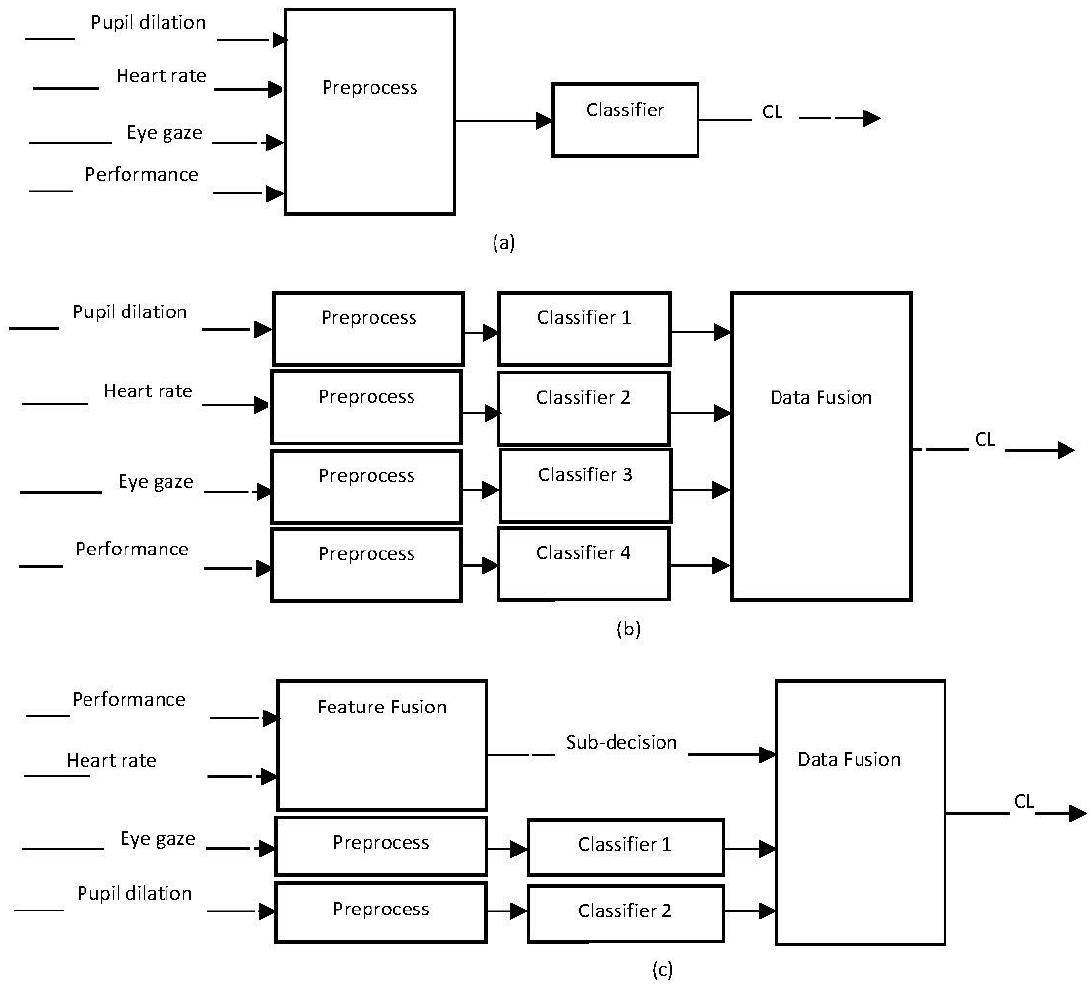
Figure 6. The structures of the three-level fusion approaches. ( a ): feature-level fusion, ( b ): decision-level fusion, and ( c ): hybrid-level fusion.